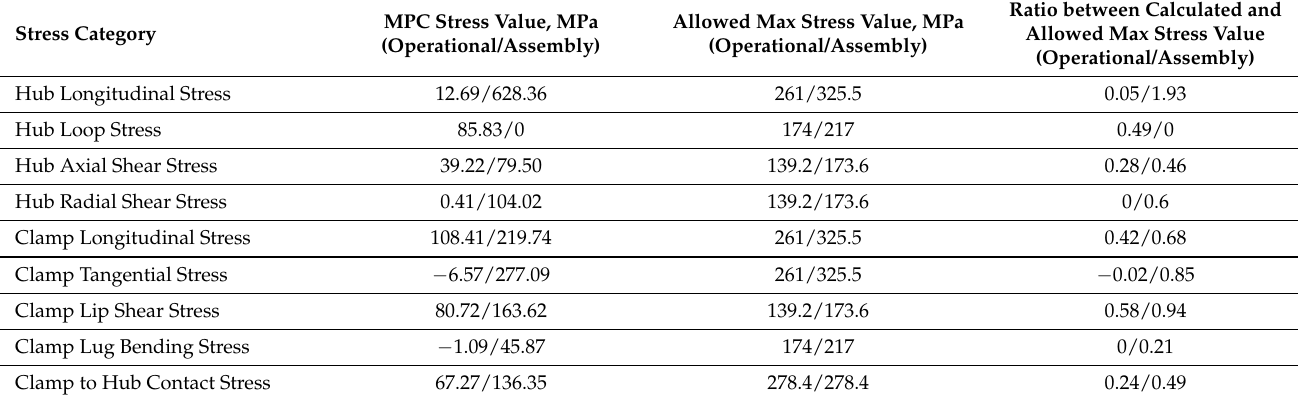
Table 3. ASME VIII-Div 1 Appendix 24 calculation